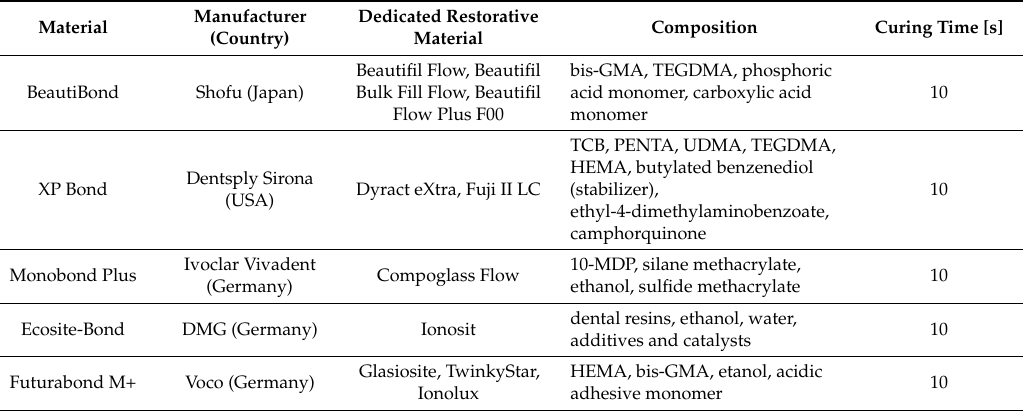
Table 2. The composition and curing time of bonding